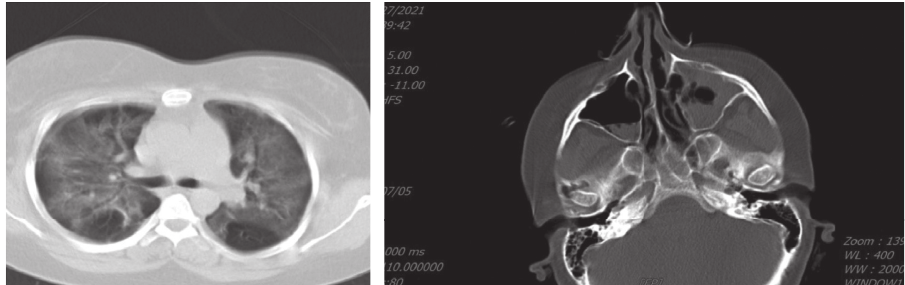
Figure 1: Ostiomeatal complex (OMC) is obstructed leading to mucosal thickening and accumulation of secretions in paranasal sinuses.